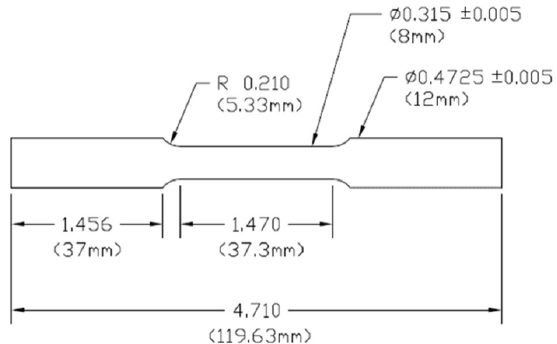
Figure 1. Dimensions of samples for the tensile test and the low-cycle fatigue (LCF) test in the presented work.